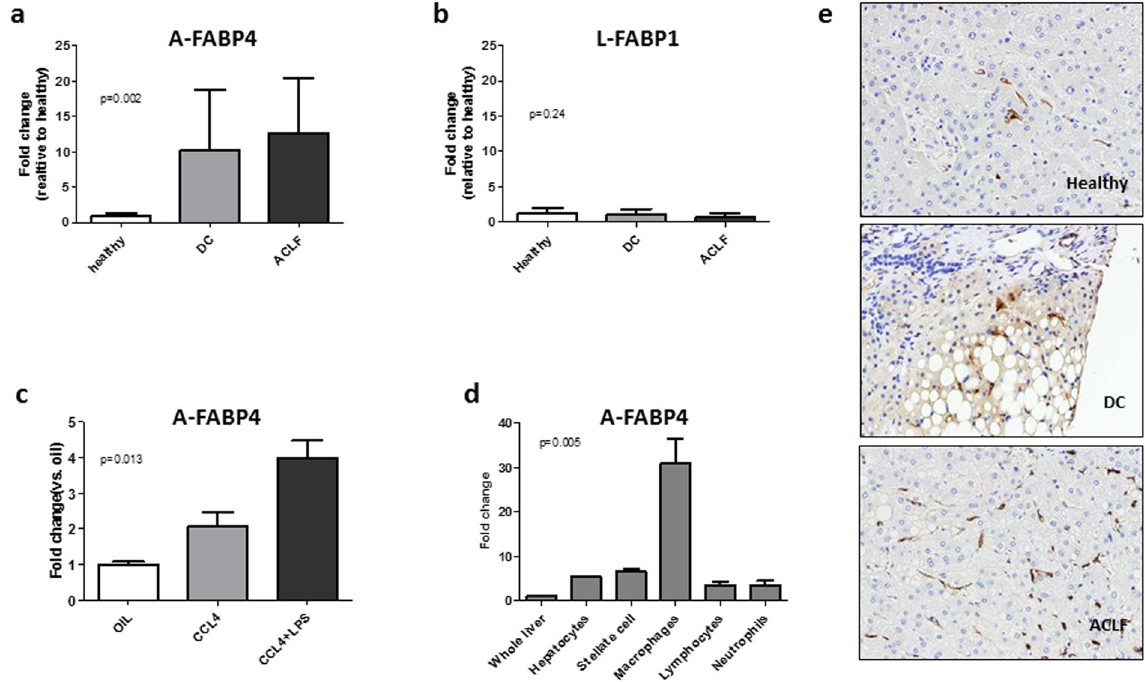
Figure 3. Hepatic gene expression of A-FABP4 and L-FABP1 in patients with decompensated cirrhosis, hepatic A-FABP4 expression in experimental model of acute-on-chronic liver injury and liver cells populations, and immunohistochemistry of A-FABP4 in human liver tissue. Panels a show relative hepatic expression, expressed as fold change, of adipocyte fatty-acid binding protein 4 (A-FABP4) in biopsies of patients with decompensated cirrhosis (n = 12) and ACLF (n = 10). Panel c shows hepatic expression of A-FABP in the whole liver of experimental models of chronic and acute on chronic liver injury (CCl4 and CCL4 + LPS). Panel d shows the expression of A-FABP4 in different liver cells populations in acute on chronic liver injury experimental model (CCL4 + LPS). Panel e shows A-FABP4 staining in liver tissue from a healthy subject, a patient with decompensated cirrhosis and a patient with ACLF. All photos show positive staining for liver